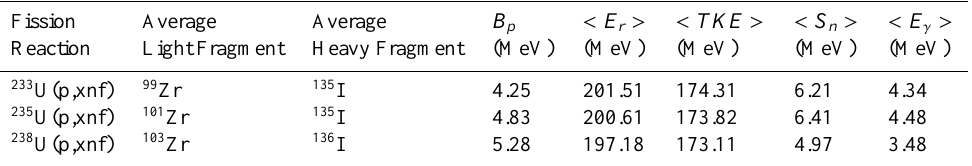
Table 1. Average values of the parameters used for calculating the prompt fission neutron spectra and average prompt neutron multiplic- ities for the reactions studied in the present work. Fission Average Average B p < E r > < TKE > < S n > < E γ > Reaction Light Fragment Heavy Fragment (MeV) (MeV) (MeV) (MeV) (MeV) 233 U(p,xnf) 99 Zr 135 I 4.25 201.51 174.31 101 Zr 135